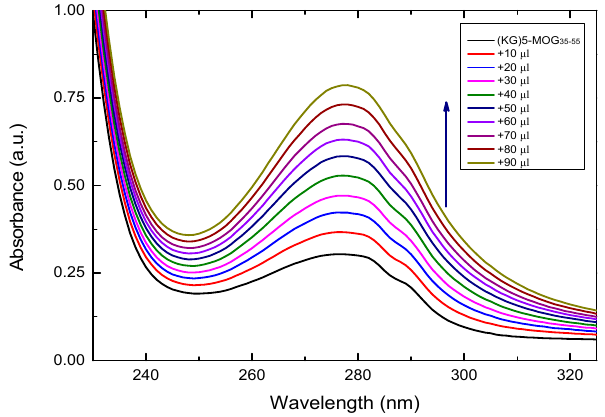
Figure 2. UV-Vis spectral changes of (KG) 5 -MOG 35-55 in solution with increasing amounts of OM (10–90 μ L).